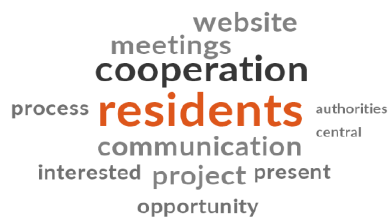
Figure 1. Word cloud of phrases that make up the Dialogue category. Source: Own research. The more often a word appears, the larger the font.